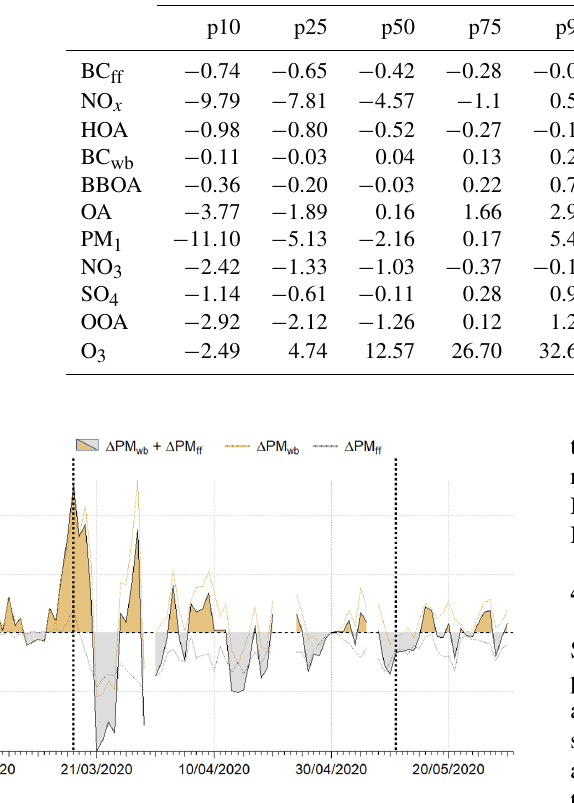
Figure 6. Temporal variations of (cid:49) PM wb + (cid:49) PM ff during lock- down. Brown shaded area shows compensation of wood burning. Individual PM wb and PM ff concentration changes are also dis- played with dotted lines. Black vertical lines delimit the start and the end of the lockdown